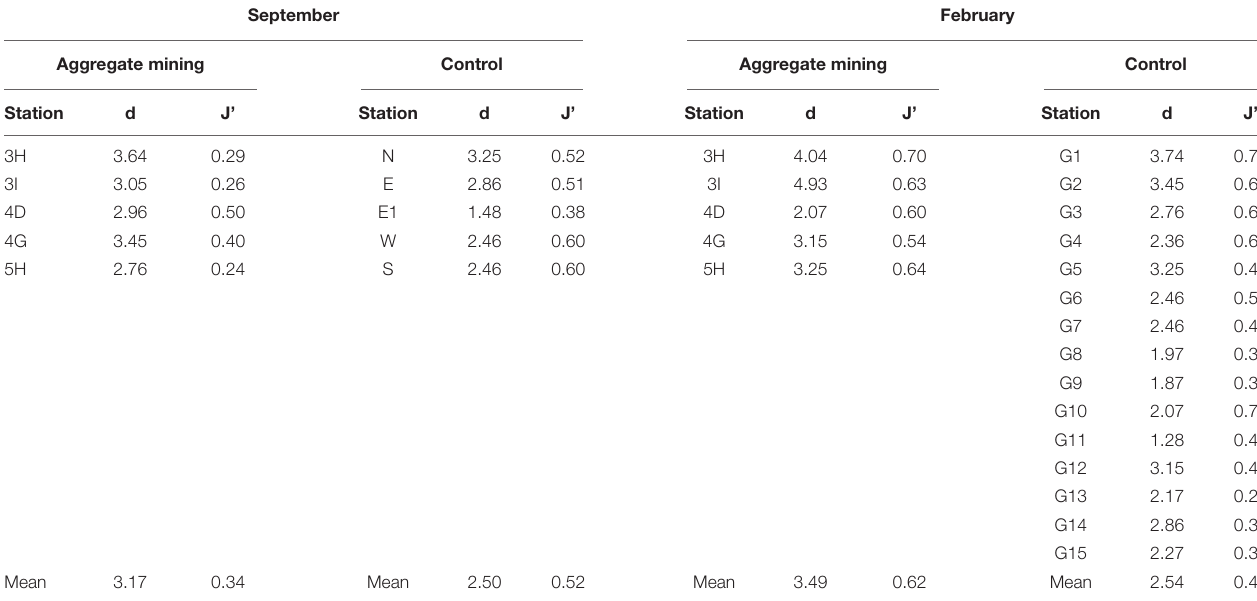
TABLE 3 | Diversity indices at each sample collection site for the fish assemblages in Korean coastal waters by eDNA metabarcoding analysis.